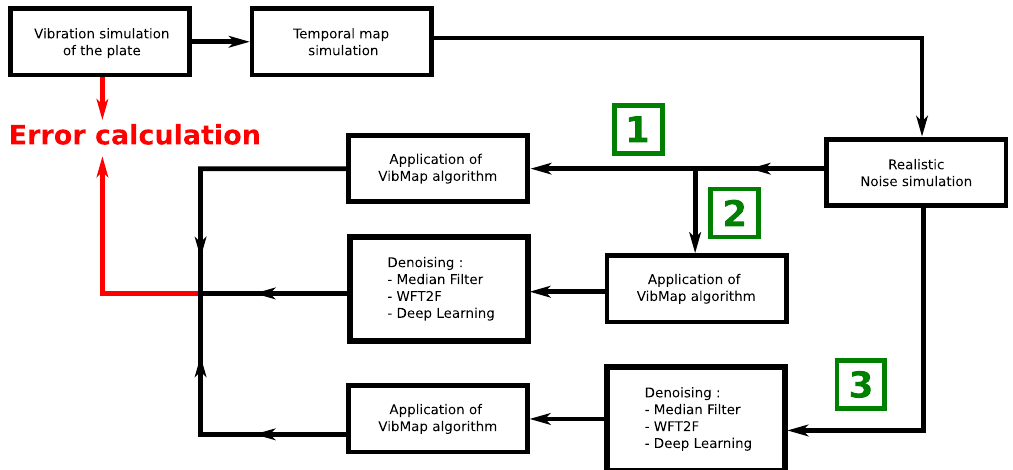
Figure 8. Different schemes for the simulation chain for data obtained from realistic simulations, green numbers 1, 2, 3 indicate the three ways for the data processing.